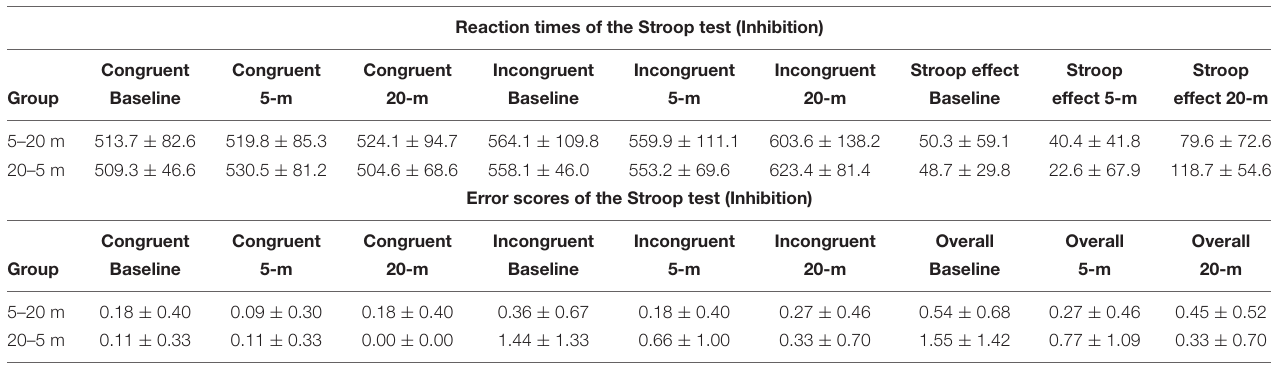
Depicted are means and standard